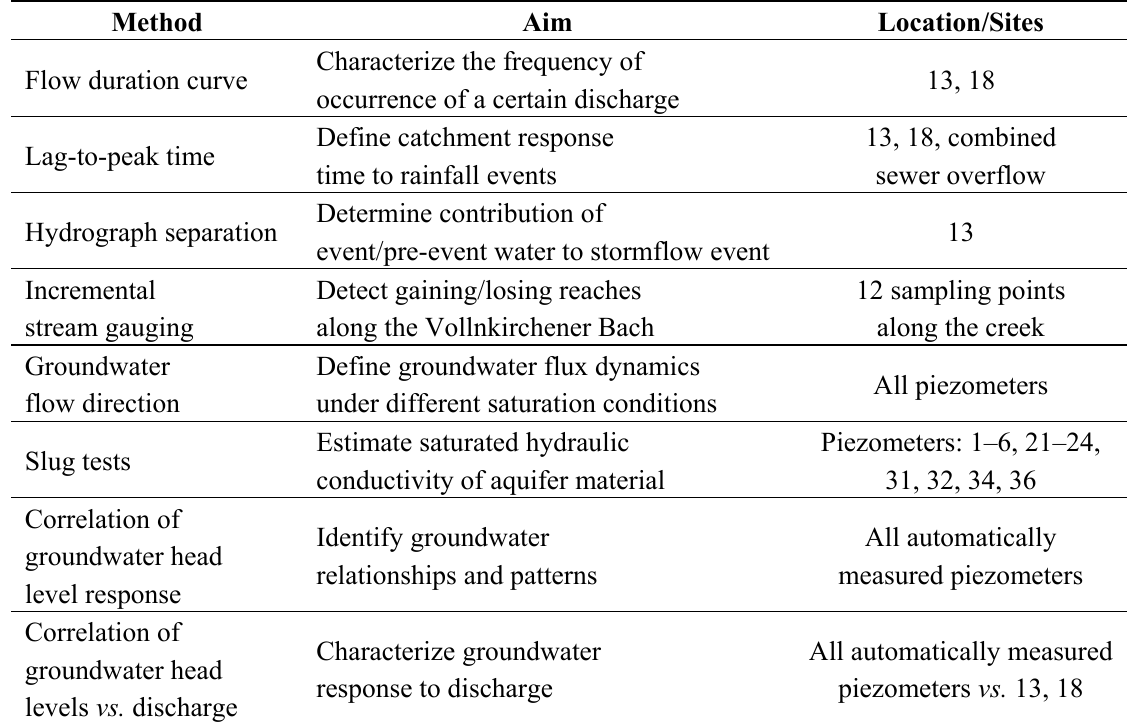
Table 2. Overview of applied surface water and groundwater measuring